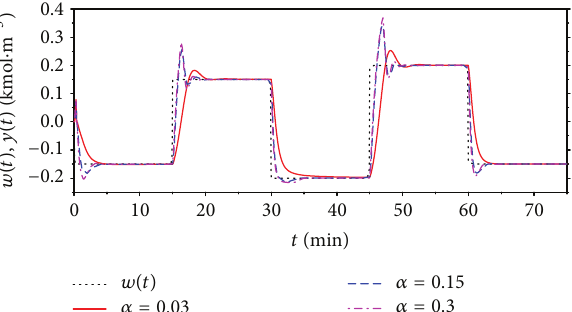
Figure 15: The course of the output variable 𝑦(𝑡) and the reference signal 𝑤(𝑡) for various values of the tuning parameter 𝛼 for classic adaptive